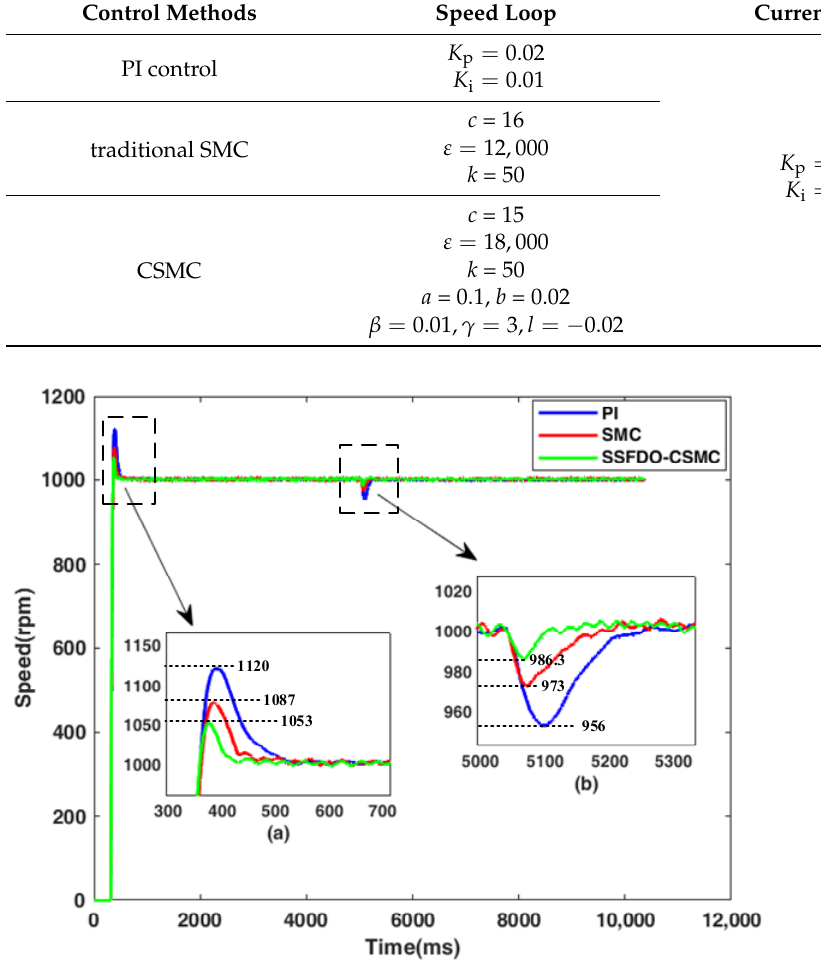
Figure 14. Actual speed response under the 0.112 N · m load: ( a ) starting performance, ( b ) disturbance rejection ability.